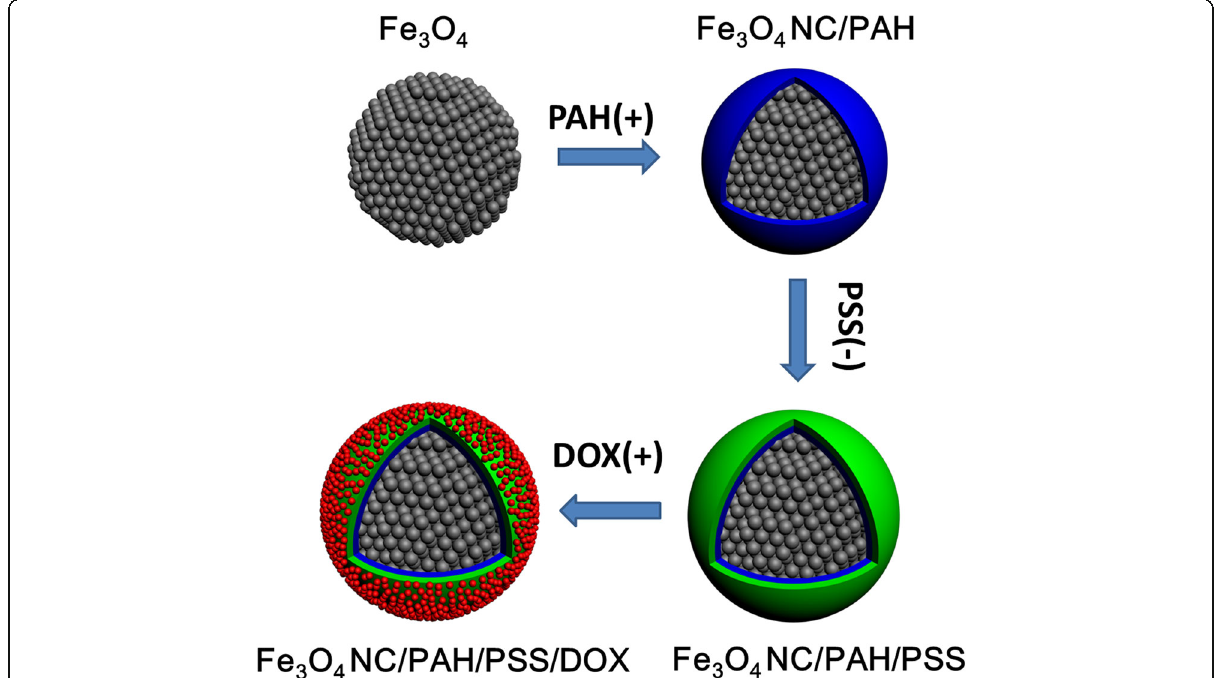
Fig. 1 Schematic illustration of synthesis of Fe 3 O 4 NC/PAH/PSS/DOX hybrid nanostructures as theranostic agents for MRI and drug